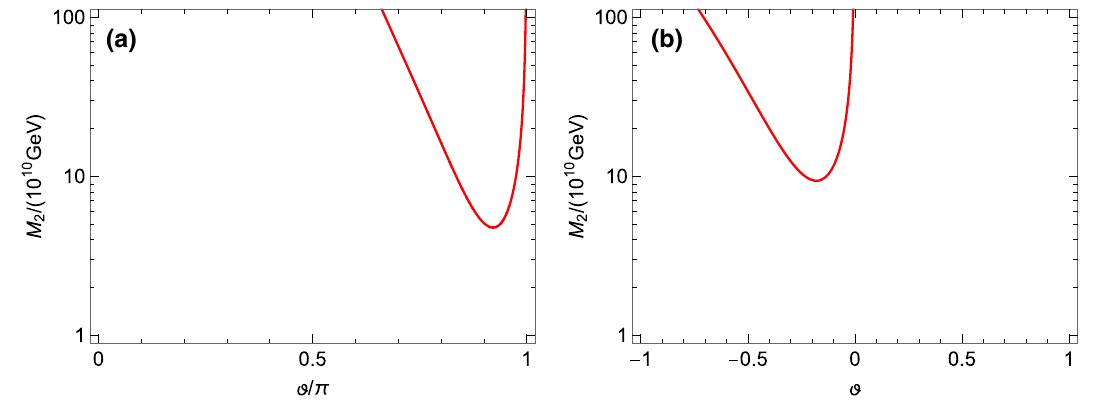
< M , the values of M versus ϑ for 2 3 2